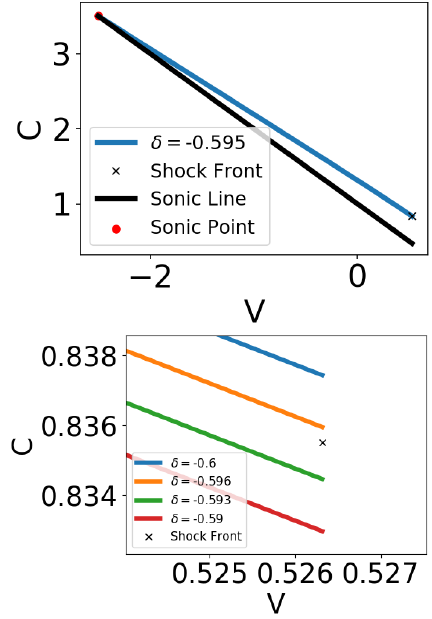
Figure 1. Numerically integrated Hydrodynamic trajectories for γ = 2.8, as an example for the general behaviour in the case γ > 2, for various values of δ . The entire domain is shown in the top panel, and a zoomed in plot at shock front point is shown in the bottom panel. The integration proceeds continuously from the sonic point (red circle) to the shock front (black cross).